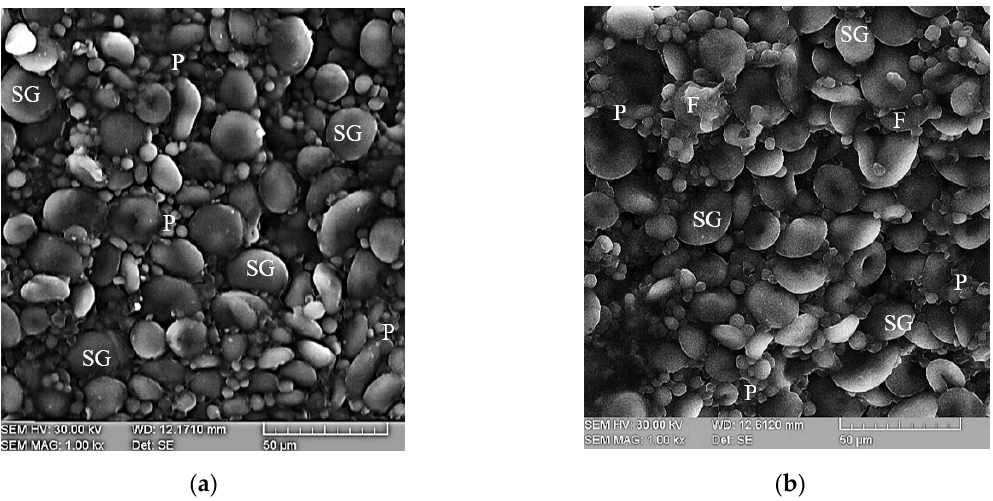
Figure 2. Dry pasta microstructure of ( a ) control and ( b ) optimal sample with grape peels (OGP): SG—starch grain; P—protein matrix; F—fiber.